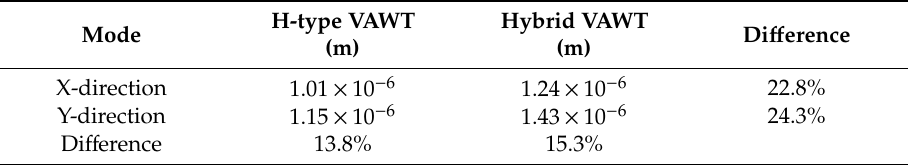
Table 15. Comparison of the maximum steady-state response amplitudes of the 4 m-mast H-type and hybrid VAWTs in X- and Y-directions from their